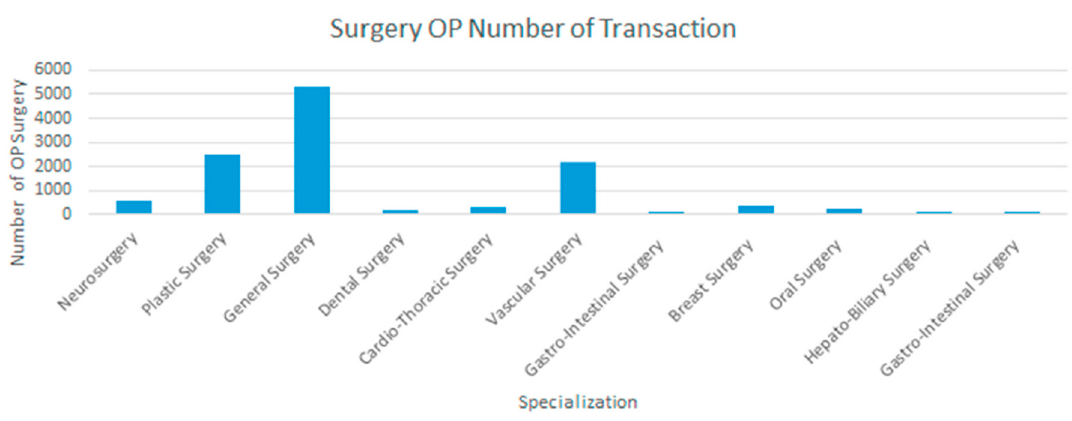
Figure 18. Smart contract deployment cost for Inpatients and Day cases (IDPC surgery) across different departments/specialities.